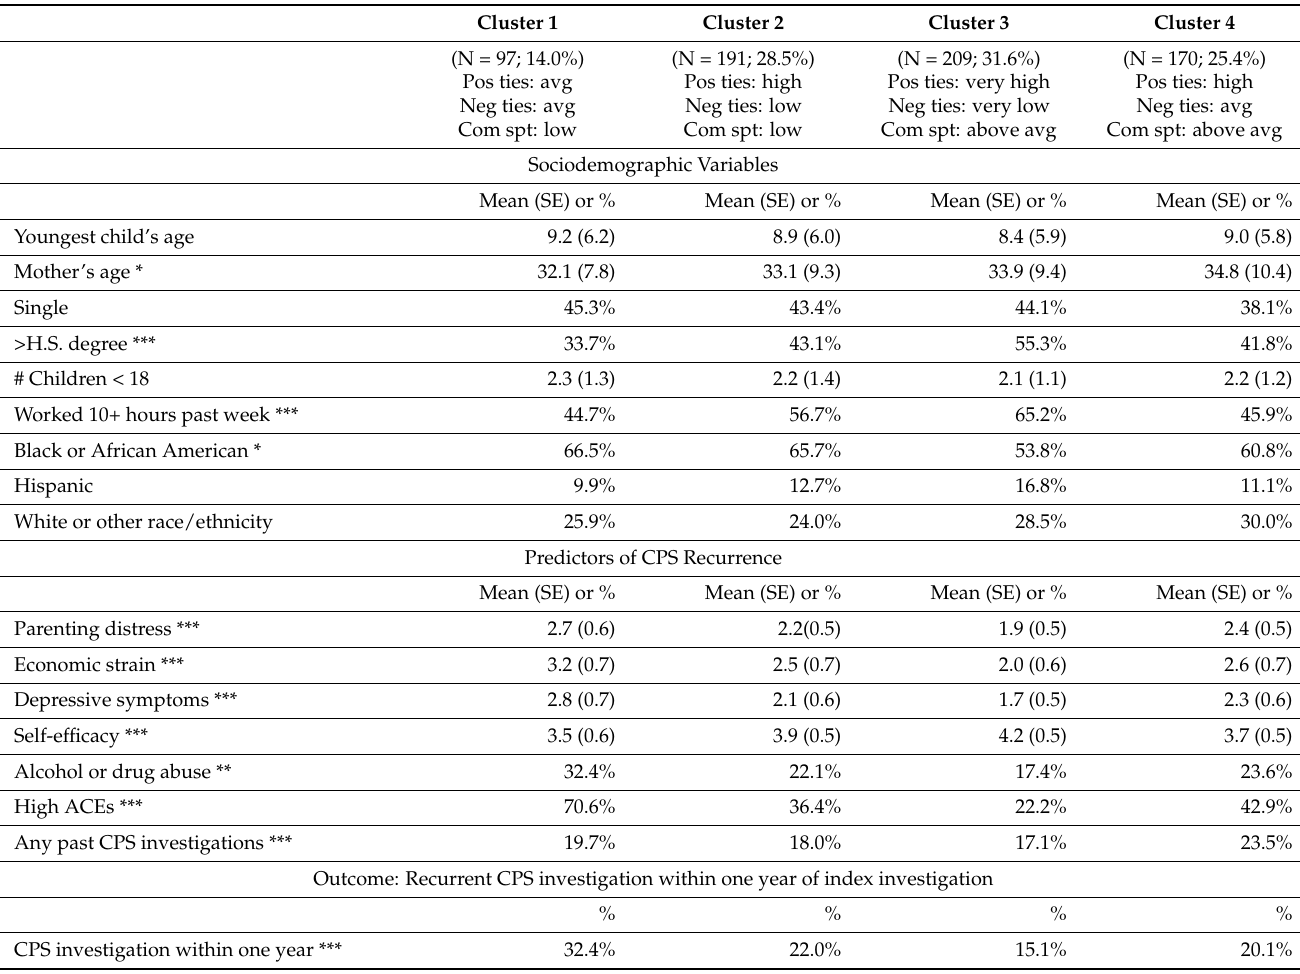
Table 3. Sociodemographic and Key Predictors by Cluster (N =